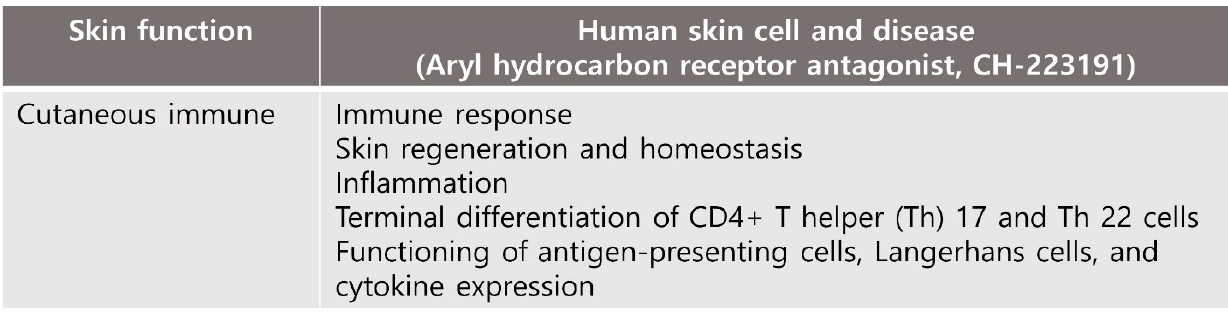
Figure 4. Skin barrier function is regulated by competition between the aryl hydrocarbon receptor (AhR) axis upregulation of barrier and downregulation of barrier. In epidermal keratinocytes, the AhR:ARNT complex initiates the activation of the OVO like 1( OVOL1 ) transcription factor, which subsequently enhances the expression of filaggrin ( FLG ) and loricrin ( LOR ) and accelerates the epi ‐ dermis to form an epidermal barrier (upregulation of barrier). Activation of the IL ‐ 13/4 ‐ JAK ‐ STAT3 axis inhibits the cytoplasmic to nuclear translocation of OVOL1 and inhibits the expression of FLG and LOR (downregulation of barrier). Studies have also provided insights into the potential the role of tryptophan ‐ derived AhR ligands by physiological and pathological processes in the skin. AhR ‐ mediated im ‐ mune response may be associated with high AhR expression in skin cells [39]. AhR is expressed on immune cells including antigen ‐ presenting cells, T cells, fibroblasts, macro ‐ phages, mast cells and other skin immune cells.; The function of antigen ‐ presenting cells, including Langerhans cells, and cytokine expression are required by the expression of AhR. [27]. Terminal differentiation of CD4+ T helper (Th) 17 and Th 22 cells and expres ‐ sion of IL ‐ 17 and IL ‐ 22 cytokines have been shown to be regulated by AhR signaling [40,41]. AhR is known to regulate the peptidoglycan ‐ induced expression of inflammatory genes in human keratinocytes. Bacterial peptidoglycan ‐ induced skin inflammation in keratinocytes is regulated by AhR, which modulates the expression of inflammatory genes [42]. In brief, AhR is involved in many skin functions, including those of the skin immune network as well as in cell homeostasis (Figure 3). 4.2. In Vivo Studies on AhR In one study, the dorsal skin of AhR ‐ null mice showed hyperkeratosis, acanthosis, and marked dermal fibrosis, suggesting a role for AhR in controlling skin differentiation [43]. Consequently, skin wounds of AhR ‐ null mice healed faster, probably because of re ‐ duced inflammation [44]. Paola Di Meglio et al. confirmed that AhR agonist 6 ‐